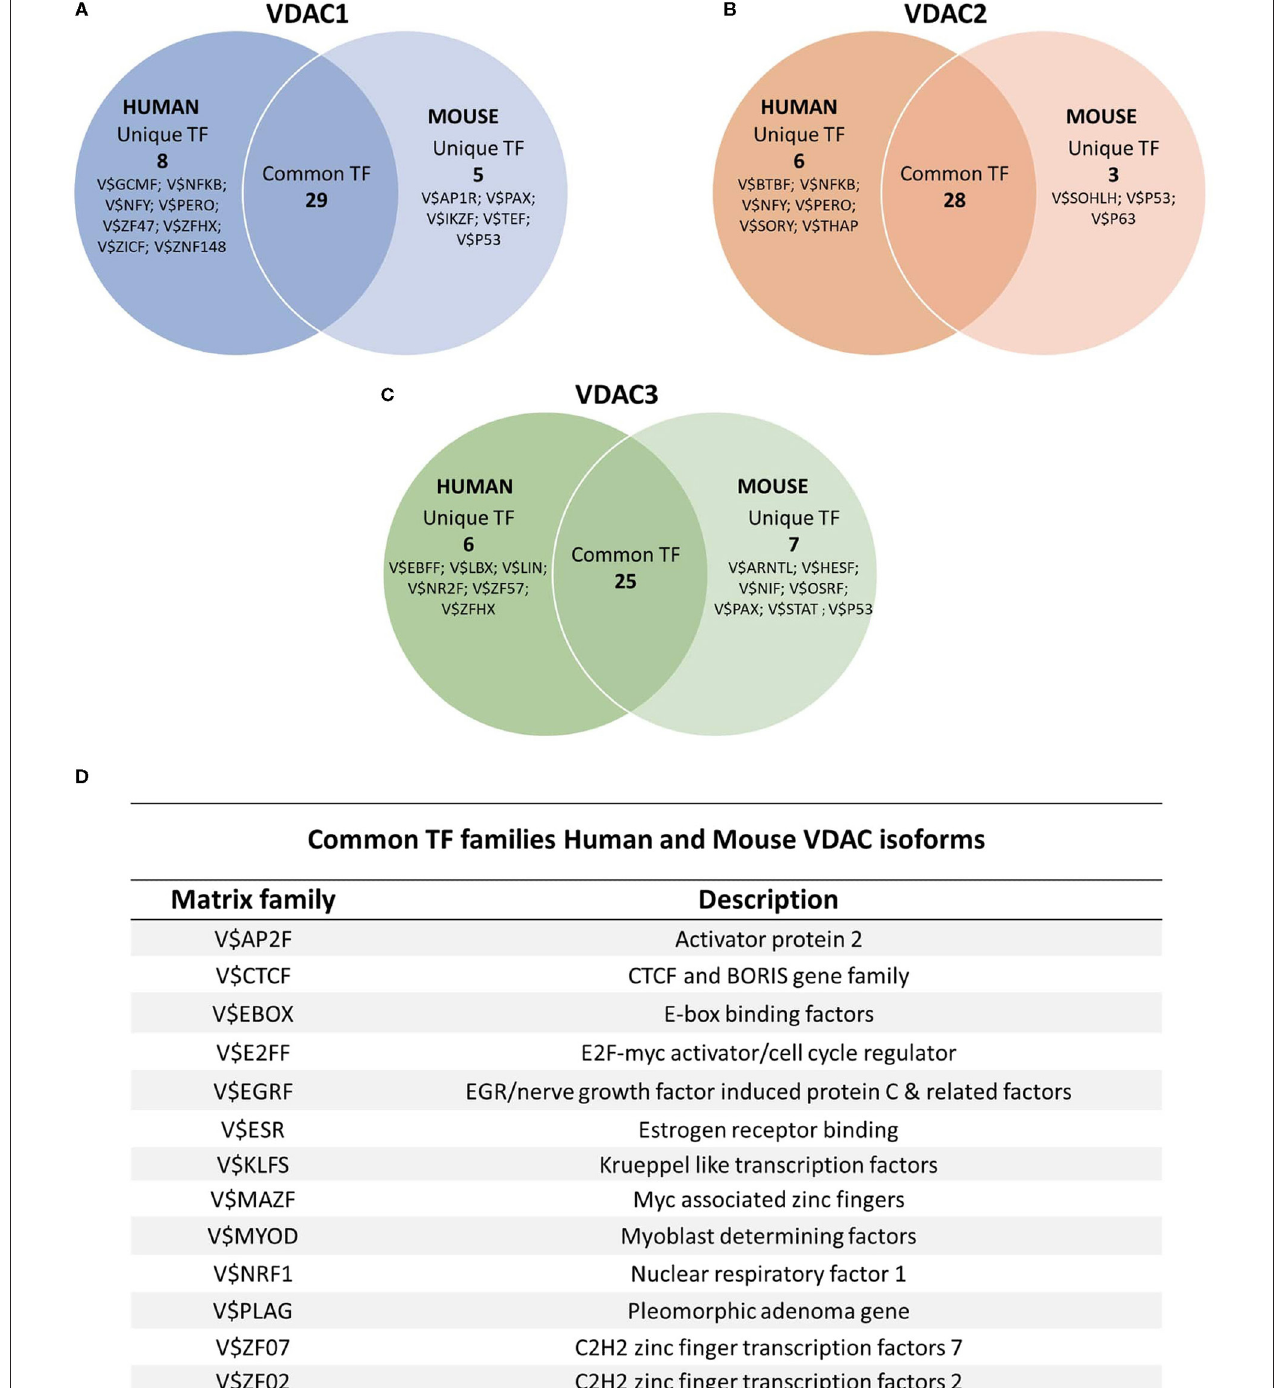
FIGURE 4 | TFBS distribution on human and mouse VDAC promoters. The sequences of human and the promoter of mouse VDAC genes were analyzed by using JASPAR (http://jaspar.genereg.net/) and UniBind (https://unibind.uio.no/) databases, and the results were overlapped to find the most relevant TF families. A comparative analysis of common and unique TFBSs for each individual VDAC isoform of human and mouse was performed. Venn diagrams showed the number of common and unique TFBS clusters between human and mouse genes in (A) VDAC1, (B) VDAC2, and (C) VDAC3 promoters. (D) The results of the common TFBS families obtained from the comparative analysis of VDAC isoforms for each species were overlain to obtain the most evolutionarily conserved transcription factor families between a human and a mouse. In the Table, the Matrix family and the description of the main TFBS families shared among the three isoforms in both species are